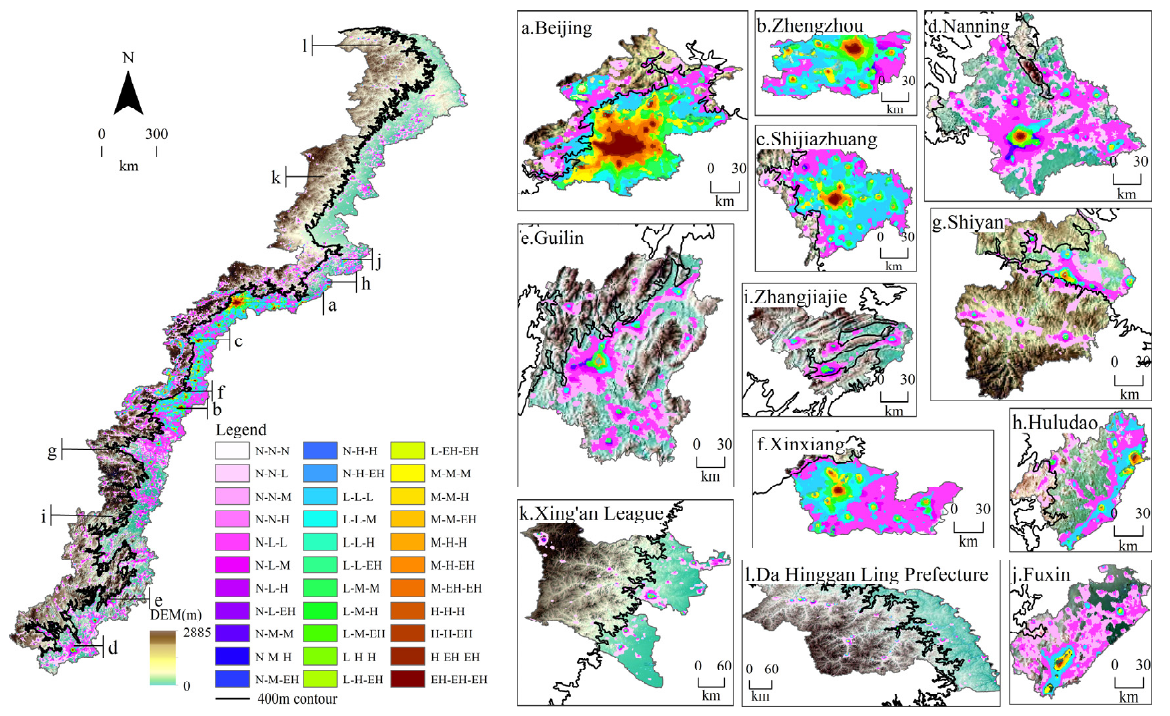
Figure 12. Superposition between the spatiotemporal transitions of different nighttime lighting types and topography.